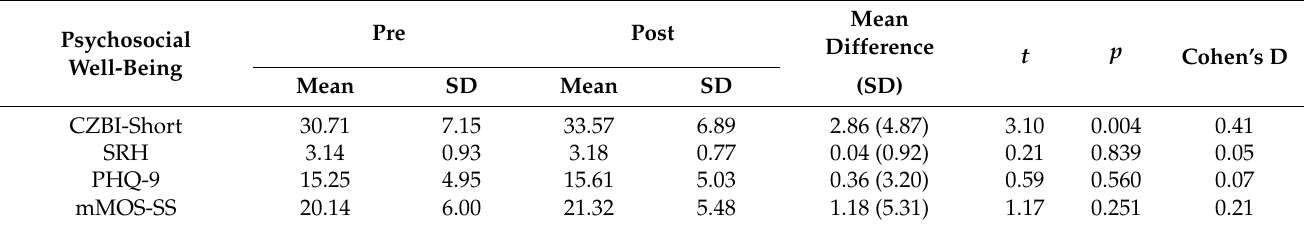
Table 3. Psychosocial Assessment before and after the use of the e-painting